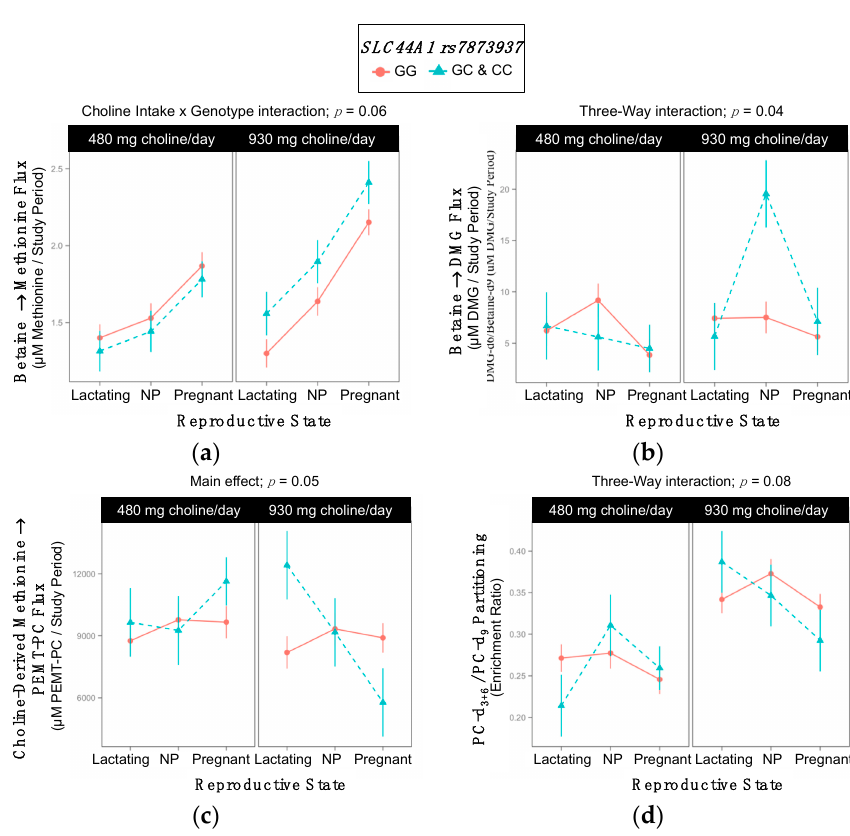
Figure 9. Effect of the SLC44A1 rs7873937 variant on the metabolic flux and partitioning of dietary choline. ( a ) Betaine → methionine flux; ( b ) Betaine → DMG flux; ( c ) Choline-derived methionine → PEMT-PC flux; ( d ) PC-d 3+6 /PC-d 9 partitioning. Table 14. Comparison of choline → CDP-PC turnover between SLC44A1 rs7873987 genotypes by choline intake group. Values are least-squared means ± standard errors in µM methionine/study period.